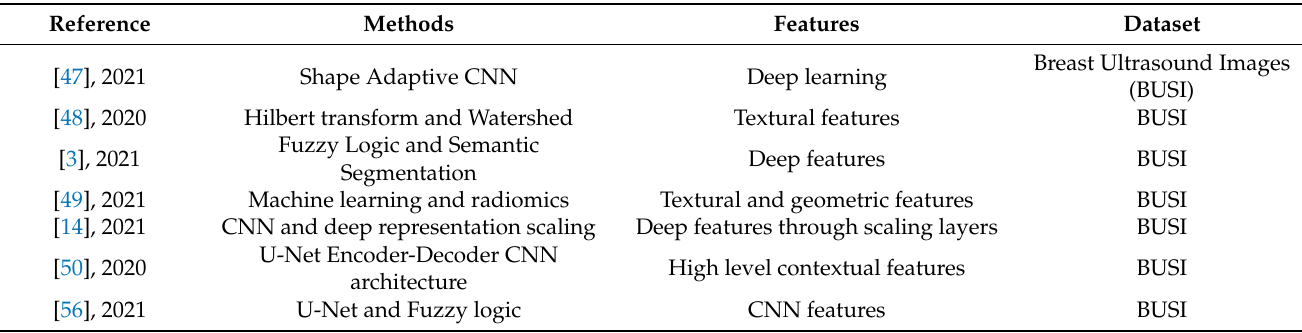
Table 1. Summary of existing techniques for breast cancer